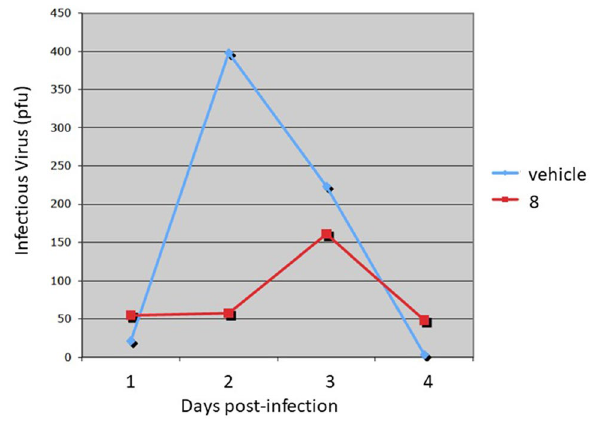
Figure 9. In vivo antiviral activity. ND4 swiss mice were infected by corneal scarification with 1 × 10 5 pfu of HSV-1 strain 17syn+. Eyes were swabbed daily for 4 days and assayed for infectious virus by standard plaque assay. Compound 8 (code R799) dramatically reduces HSV-1 shedding in the mouse